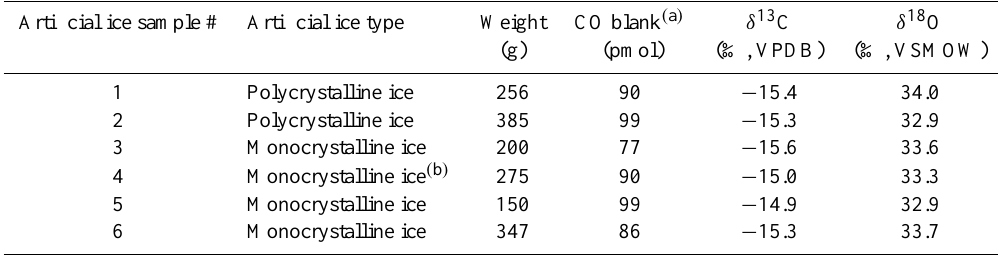
Table 3. System blank using calibration gas and artificial bubble-free ice. Artificial ice sample #